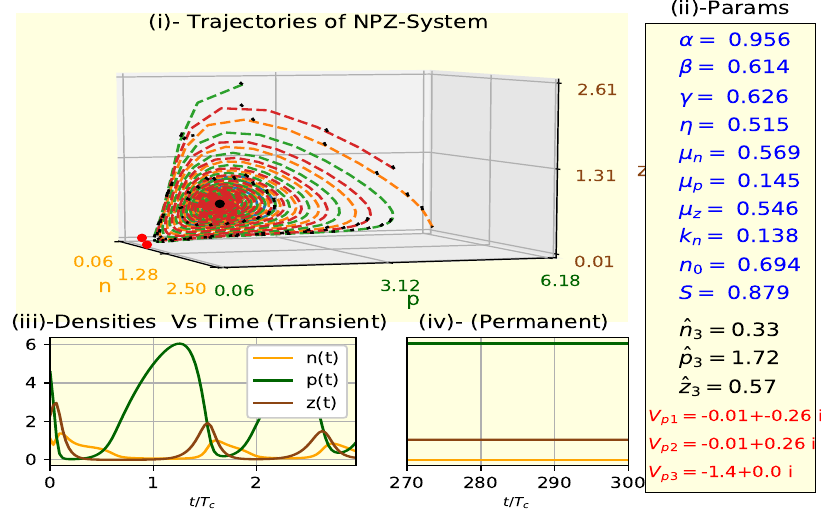
Fig. 6: Same as caption in Figure 5. Case where equilibrium e